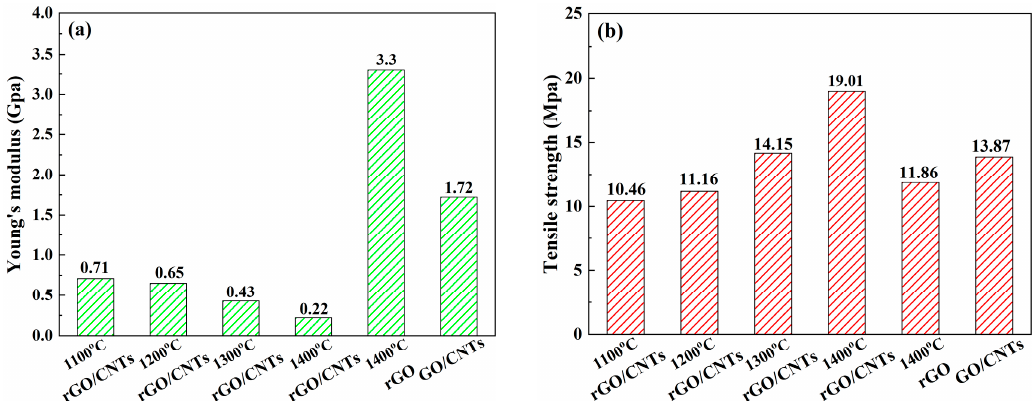
Figure 6. Mechanical properties of the rGO / CNT composite films with di ff erent annealing temperatures comparedwiththoseoftherGOfilmafterannealingat1400 ◦ C:( a )Young’smodulus; ( b